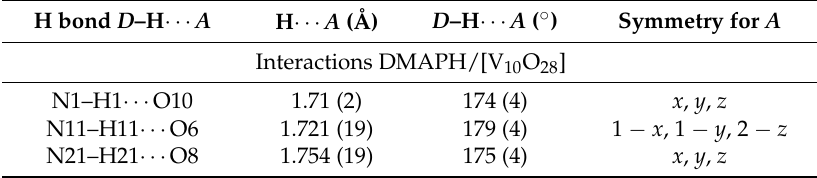
Figure 1. Structure of compound 1 , (DMAPH) 6 [V 10 O 28 ]·H 2 O, with displacement ellipsoids shown at the 50% probability level. Hydrogen bonds linking cations and anions are represented by dashed lines. The site occupation factor for the water molecule O30 is 1/2. The inset displays the arrangement of clusters in the crystal [27]. Table 1. Hydrogen bonds in the crystal structure of 1 , (HDMAP) 6 [V 10 O 28 ]·H 2 O.